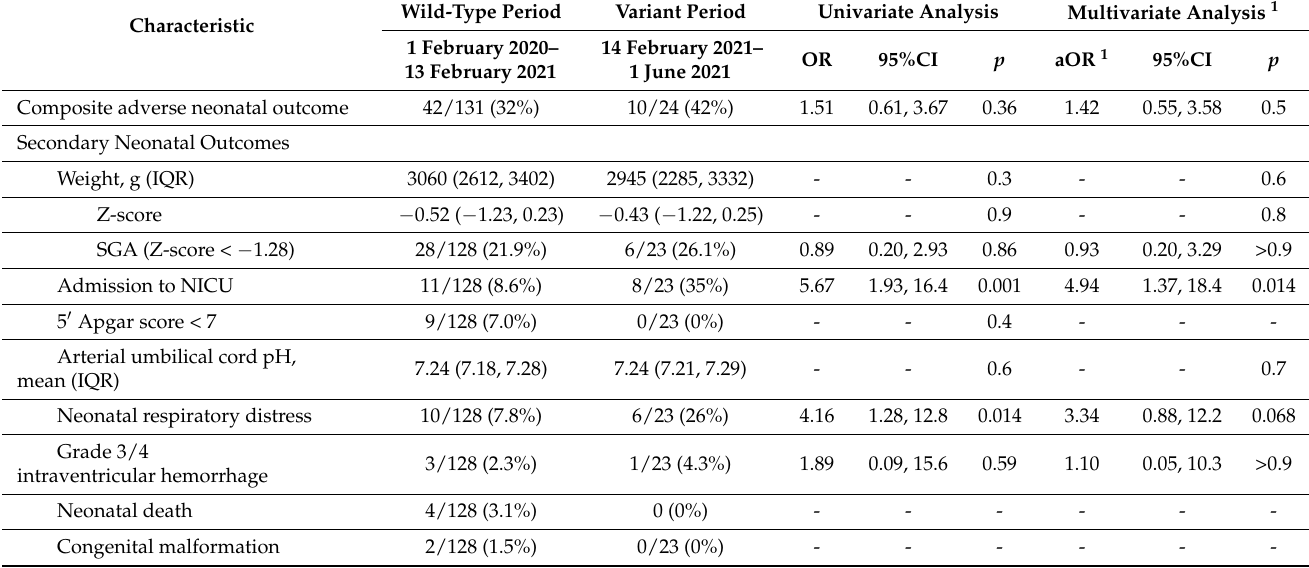
Table 4. Neonatal outcomes among symptomatic pregnant women during the “wild-type period” and “variant